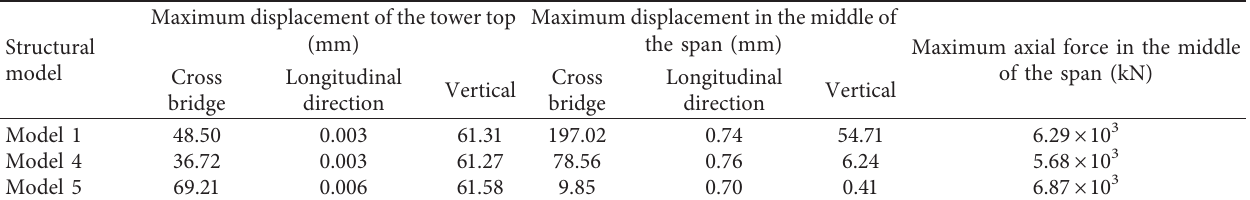
Table 8: Displacements and axial forces of the three structural models under the transverse bridge direction +1/2 vertical excitation. Maximum displacement of the tower top Maximum displacement in the middle of (mm) the span (mm) Maximum axial force in the middle of Structure type Longitudinal Vertical bridge